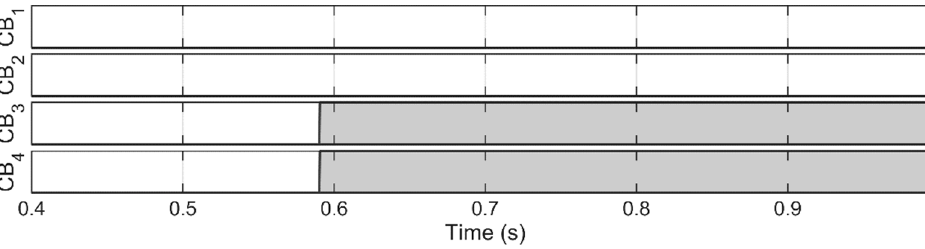
Figure 11. Operation of circuit breakers in case DCRs operate normally.